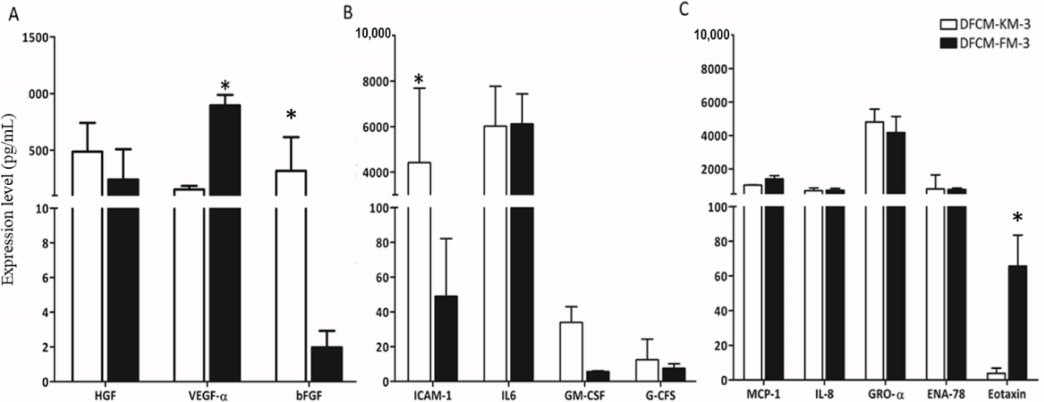
Figure 2. Wound-healing mediators on DFCM. ( A ) Growth factors, ( B ) cytokines, and ( C ) chemokines in DFCM quantified by multiplex ELISA. Here, * indicates significantly different compared to respective culture